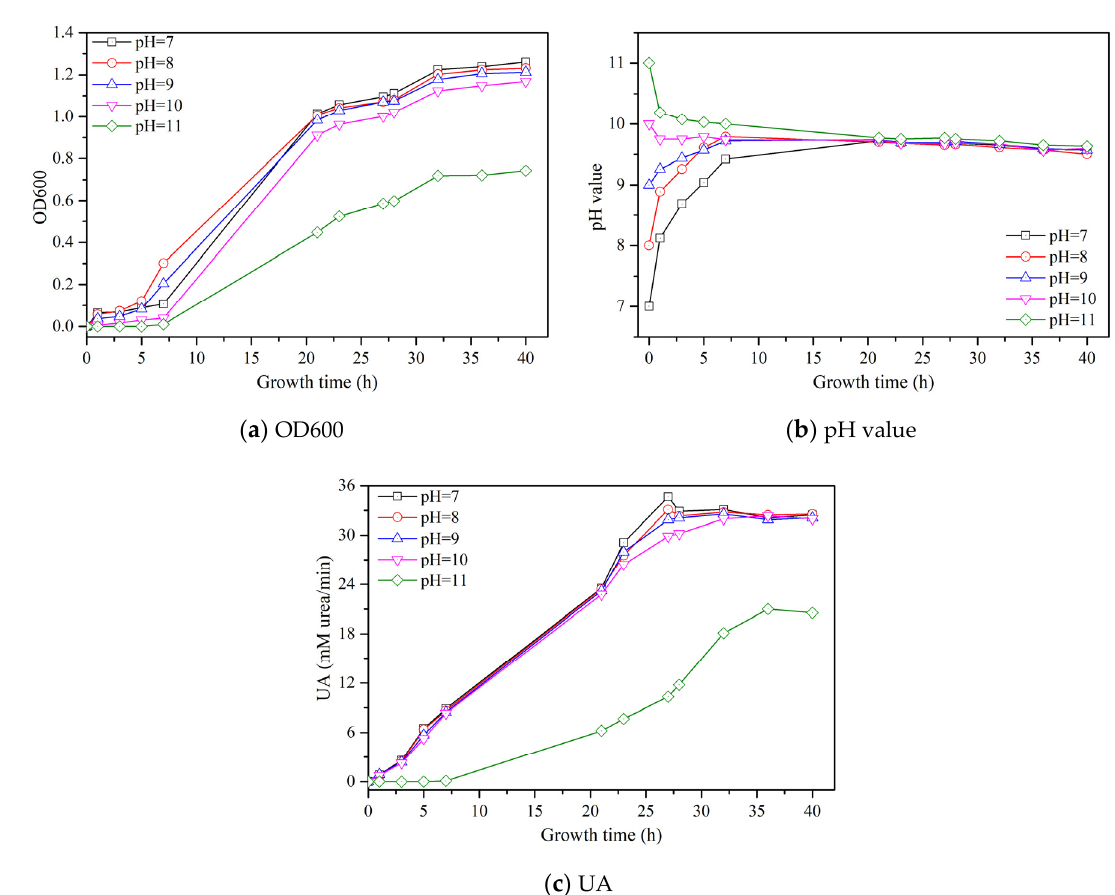
Figure 1. Effect of growth time on the OD600, pH and UA of bacterial solution under different initial pH values. As seen in Figure 1a, the change of OD600 with growth time represents the growth curve of S. pasteurii . The growth curves of all samples can be divided into three stages from Figure 1a: a lag phase, an exponential phase, and a stationary phase. During the lag phase, S. pasteurii tends to adjust to the high nutrient environment and prepares for fast growth [19]. During the exponential phase, the growth of cells becomes faster and con-